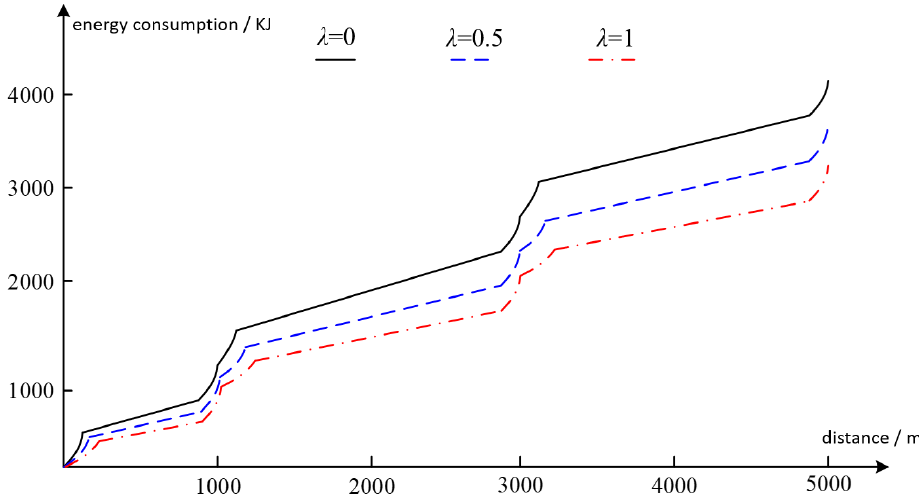
Figure 4. Energy consumption versus driving